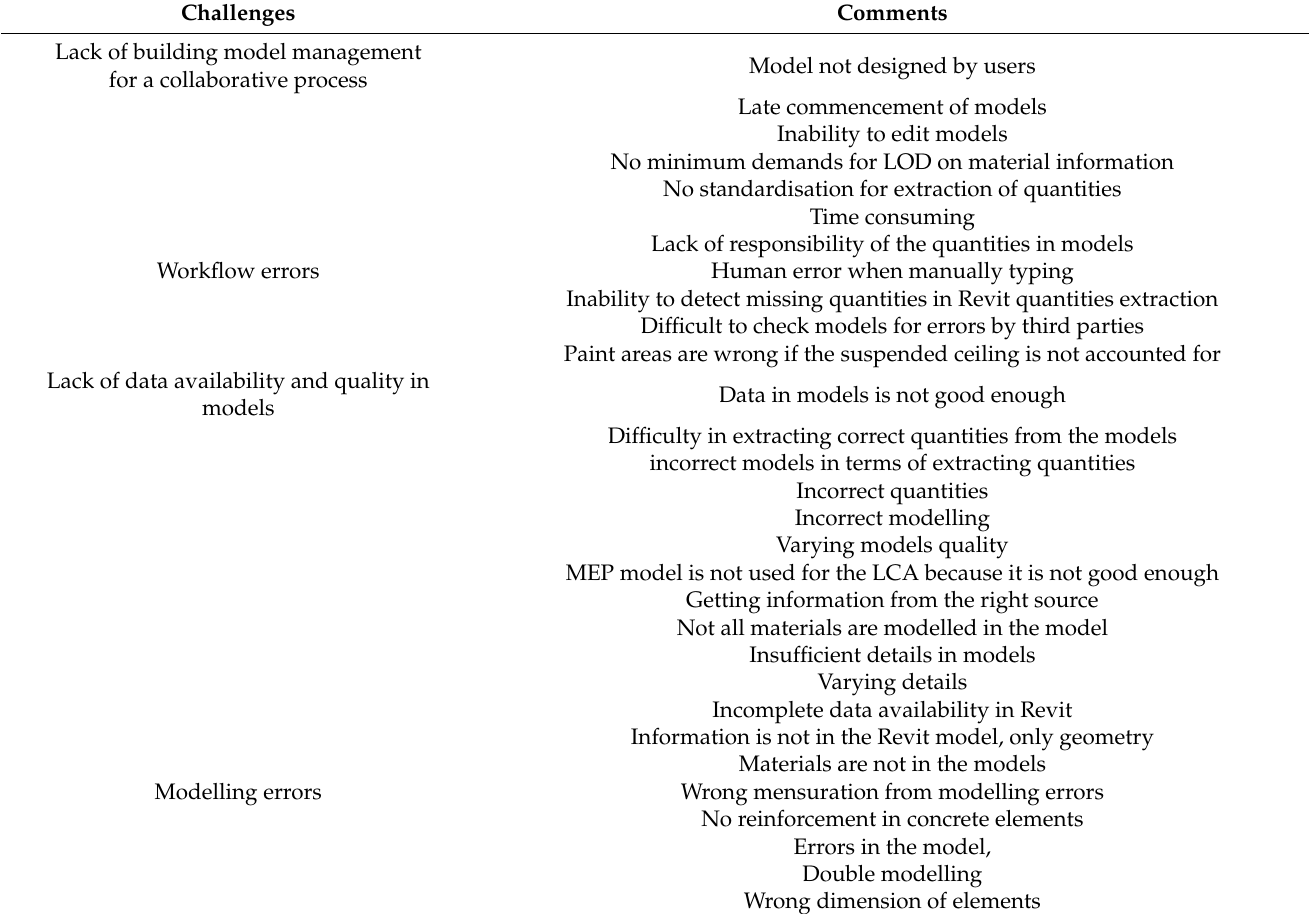
Table 1. Comments on challenges to sustainability assessment integration with BIM for buildings